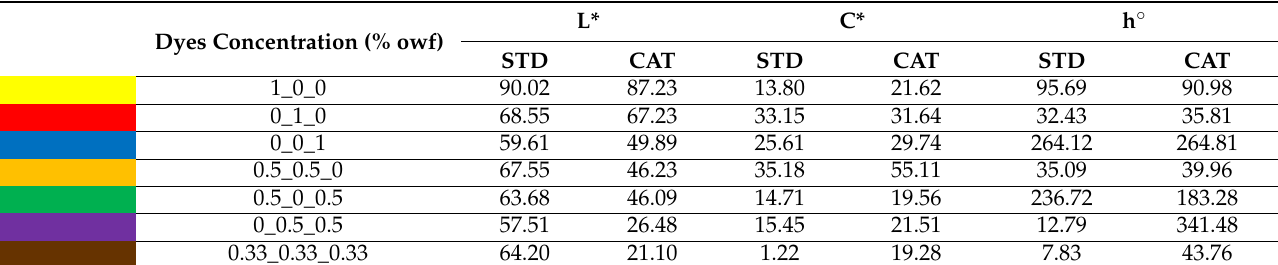
Table 3. Color parameters of standard and cationized fabrics dyed with 1% owf vat dye. Dyes Concentration (%